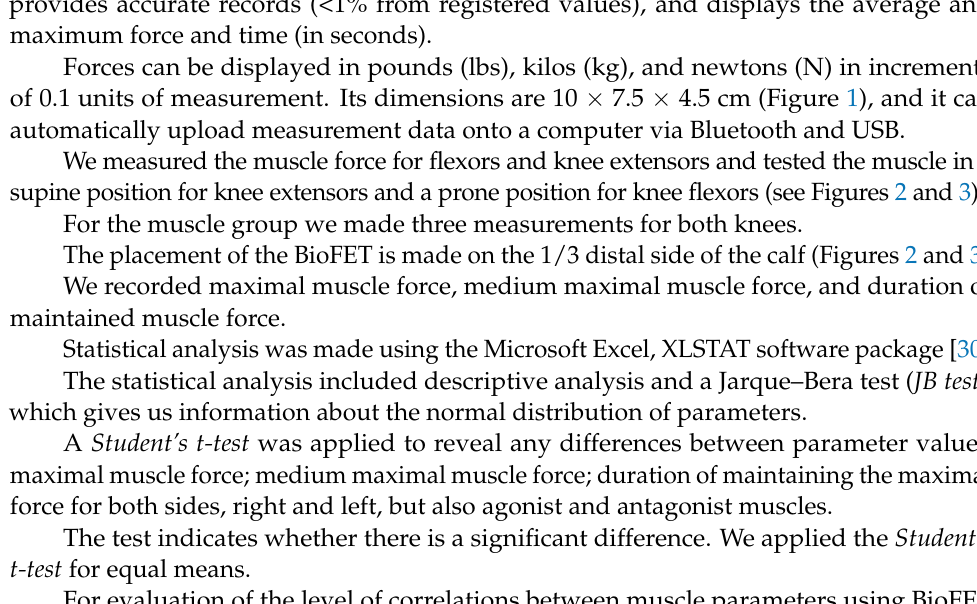
Figure 2. Test of knee flexors.